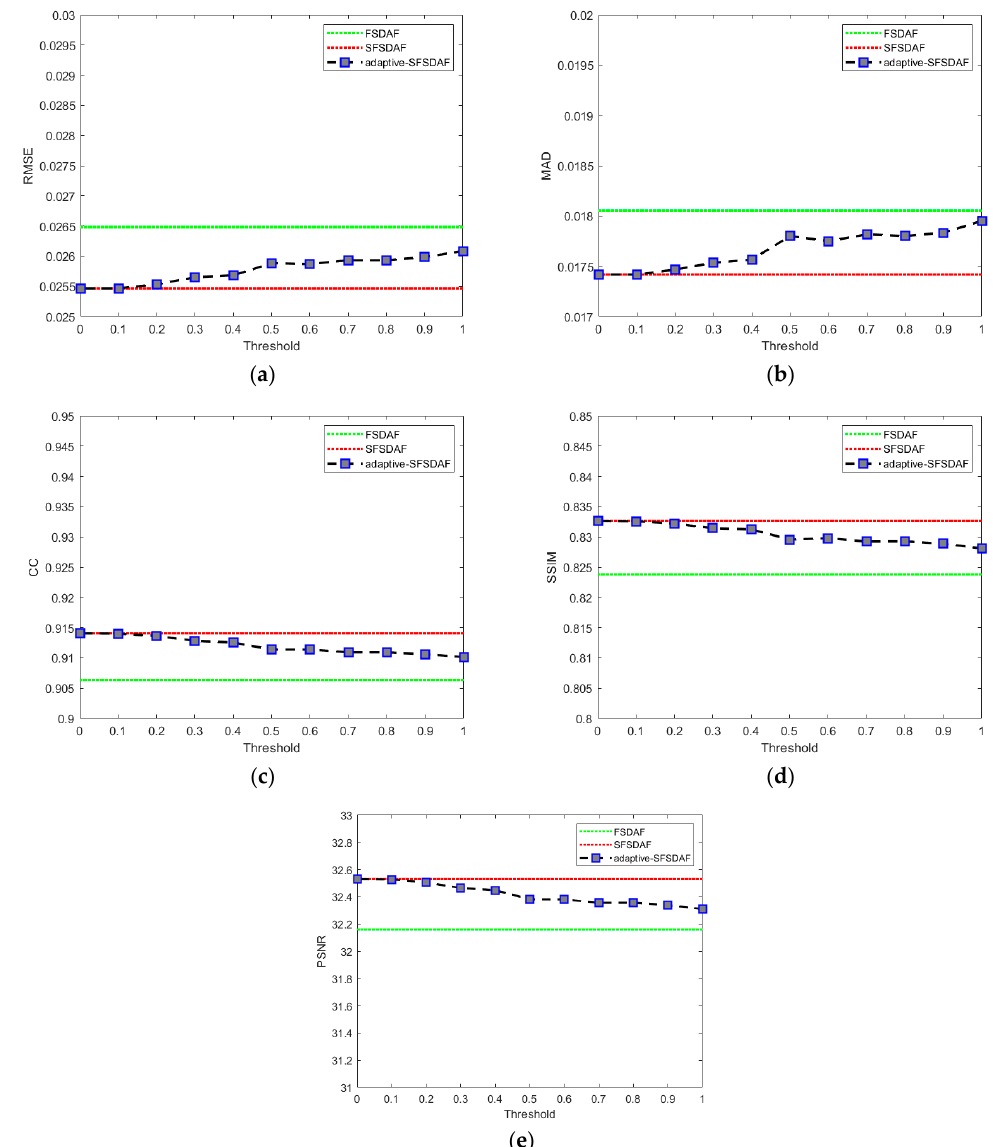
Figure 9. Adaptive-SFSDAF accuracy indices versus the mask threshold for the Coleambally site: ( a ) RMSE, ( b ) MAD, ( c ) CC, ( d ) SSIM, and ( e ) PSNR. All results are the mean of total six bands.